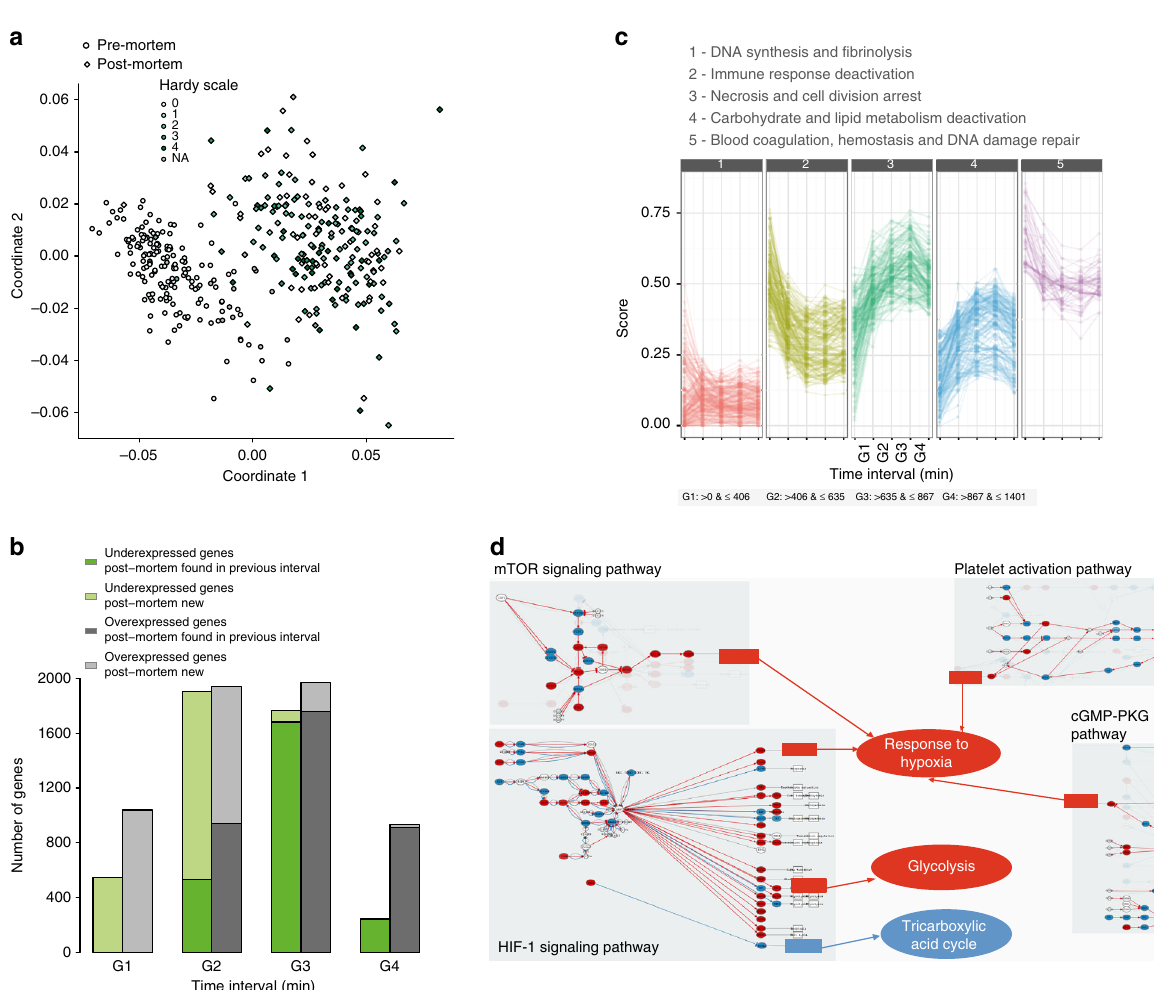
Fig. 6 Transcriptional changes in blood after death. a Multi-Dimensional Scaling of blood samples shows separation between pre and post-mortem samples. Samples are colored by the Hardy scale of the cause of death. b Number of genes differentially expressed between the pre-mortem samples and the post-mortem samples strati fi ed at different PMI intervals. Darker fi lling corresponds to genes that are found as differentially expressed in the previous interval. c The fi ve main temporal patterns of change in functional activities upon organismic death. d Hypoxia seems to play a major role in the pre-to post-mortem transcription as re fl ected in the way in which the carbohydrate metabolism is affected (activations in red, deactivations in blue). Response to hipoxia is activated from pathways “ Platelet activation pathway ” and “ cGMP-PKG signaling pathway ” through the activation of the corresponding circuits that end in the effector gene ITPR1, annotated as Response to hypoxia, and from pathways “ HIF-1 signaling pathway ” and “ cGMP-PKG signaling pathway ” through the activation of the effector gene VEGFA. The “ HIF-1 signaling pathway ” also activates Glycolysis through the activation of different circuits that trigger effector proteins (PDK1, PFKL, ALDOA, etc.) with annotations such as glycolytic process, canonical glycolysis, glucose metabolic process, etc. The “ HIF-1 signaling pathway ” also inhibits Tricarboxylic acid cycle through the inhibition of circuits that trigger the effector protein PDHA1 with diverse GO annotations such as tricarboxylic acid cycle, acetyl-CoA biosynthetic process from pyruvate or carbohydrate metabolic